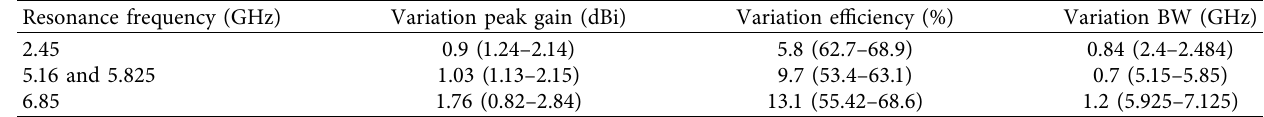
Table 3: Resonant frequency, gain, efficiency, and bandwidth of antenna.